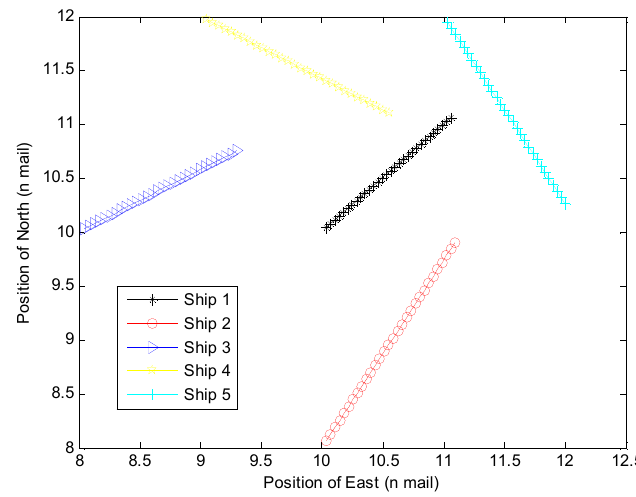
J. Mar. Sci. Eng. 2020 , 8 , x FOR PEER REVIEW Figure 2. The position curses of the target ship and its adjective ships. Figure 2. The position curses of the target ship and its adjective ships.